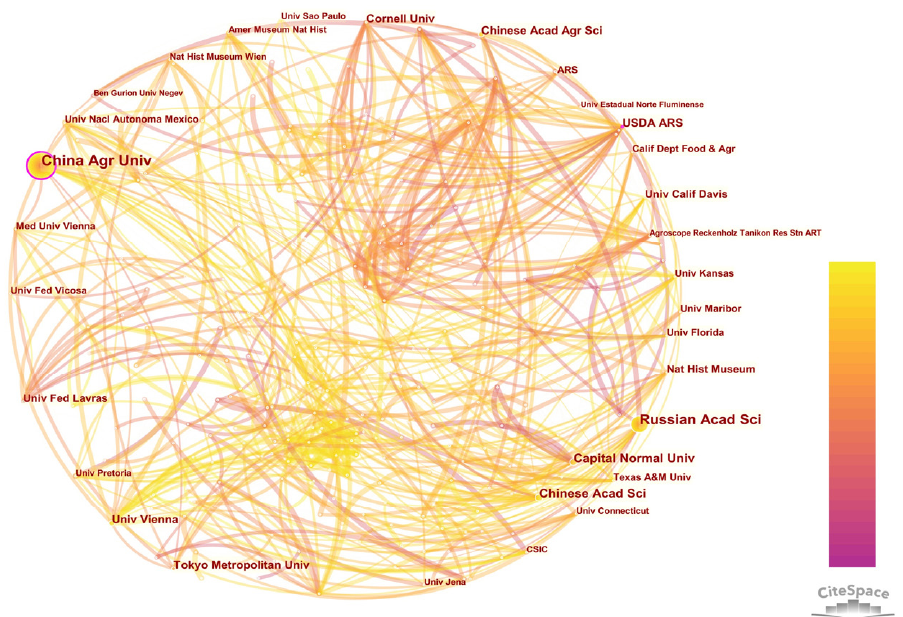
Figure 7. Institution collaboration network. The node size represents the institution’s publication frequency, and the connection line between nodes represents cooperation. High-centrality nodes are marked by a purple circle, which means the institution has facilitated communication with other institutions. Table 6. Top 20 institutions based on occurred frequency.